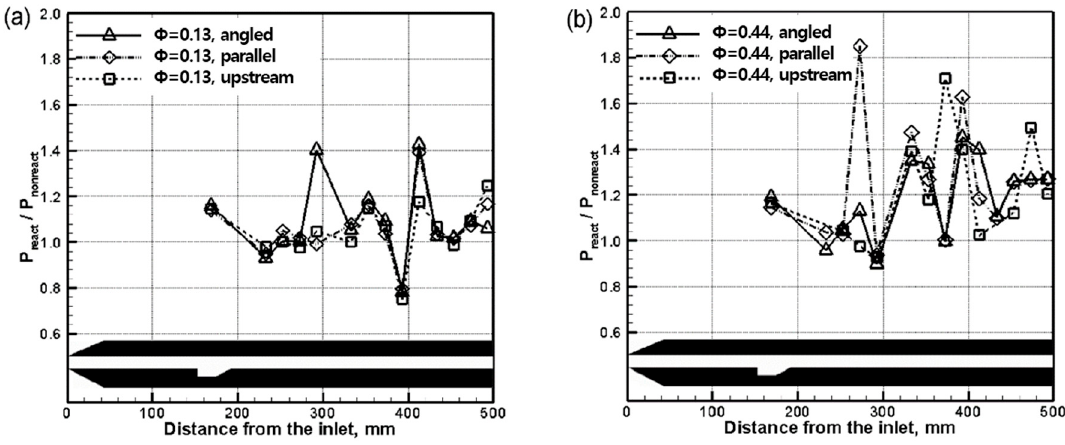
Figure 7 . Combustion effect: ( a ) Φ = 0.13, ( b ) Φ = 0.44.